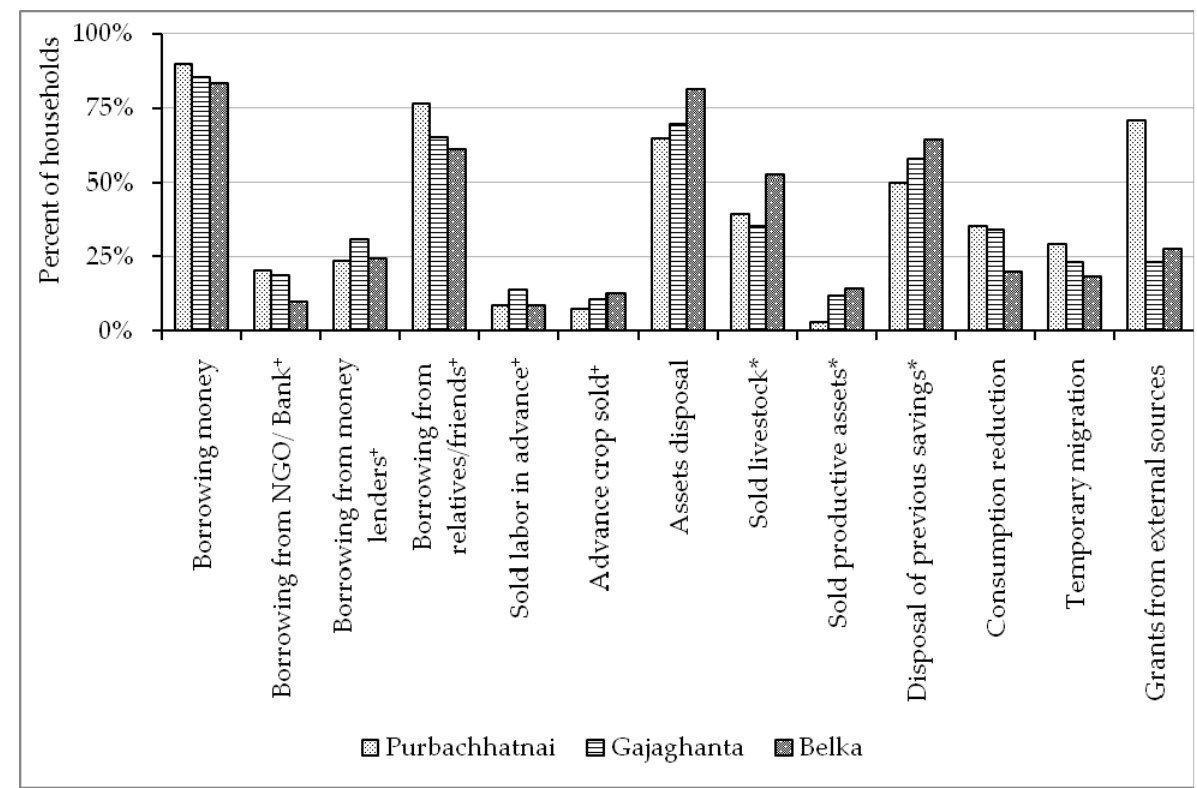
Figure 2. Geographical variations of post-disaster coping strategies in the study area (Source: Field Survey, 2019). Note: + Coping strategies within borrowing money category; * Coping strategies within assets disposal category.